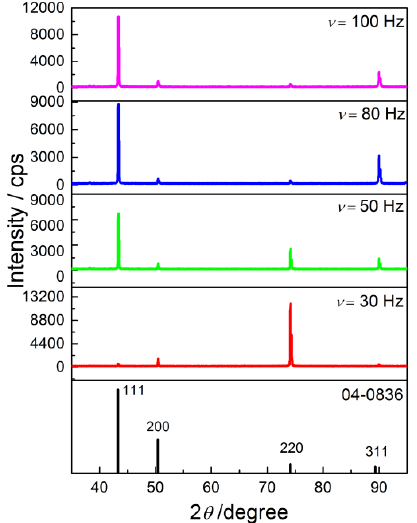
Figure 4. The XRD patterns of Cu coatings obtained by the PC regimes at frequencies of 30, 50, 80 and 100 Hz, and Cu standard (04-0836). 100 Hz, and Cu standard (04-0836).